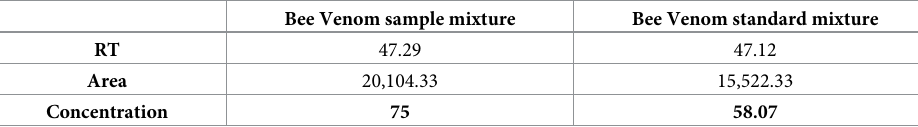
Table 1. HPLC single-point calibration method for the analysis results of the bee venom